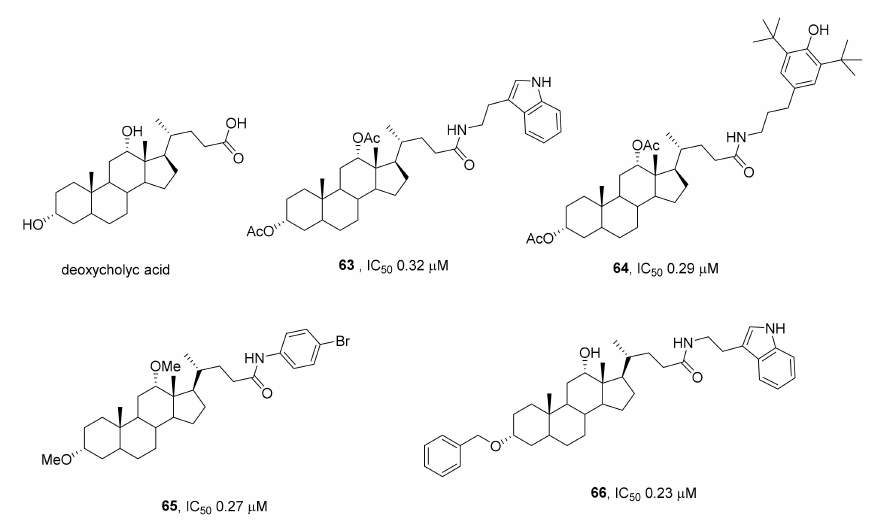
Figure 18. TDP1 inhibitors based on deoxycholic acid